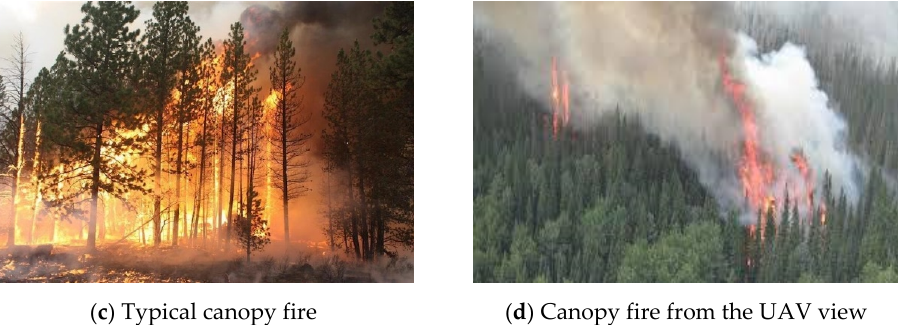
Figure 1. Training image samples in the dataset. ( a , b ) Surface fires and ( c , d ) canopy fires.